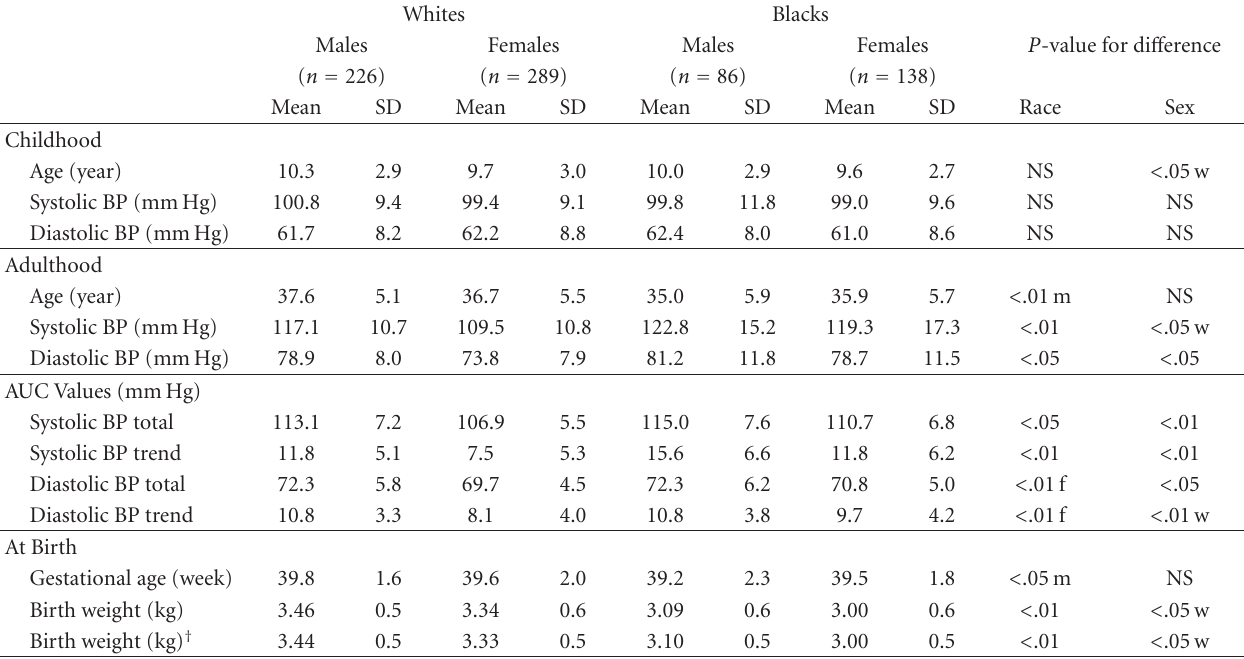
Table 1: Mean Levels and SD of Study Variables by Race and Sex. Whites Blacks